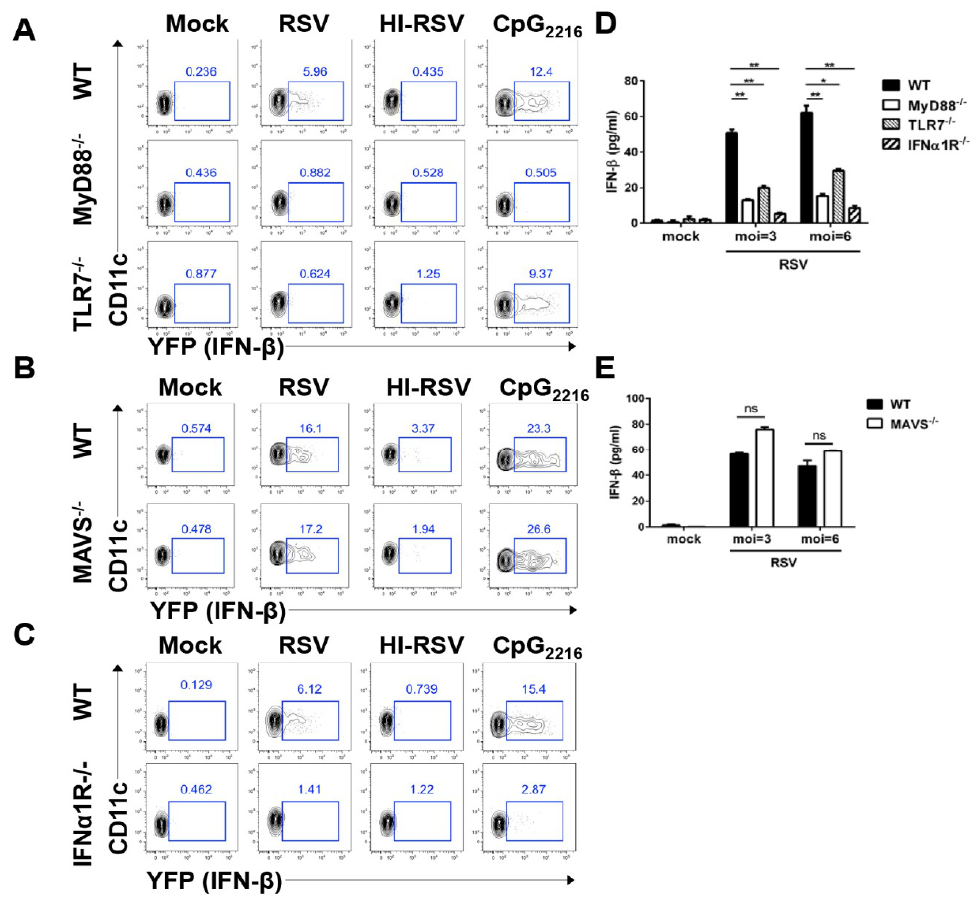
Figure 3. Interferon-β production is dependent on the MyD88-mediated pathway in pDCs in vitro. (A – C) BM cells from interferon-β YFP/reporter (WT), MyD88-deficient interferon-β/YFP reporter (MAVS −/− ) mice ( B ), or interferon-α1R-deficient interferon-β/YFP reporter